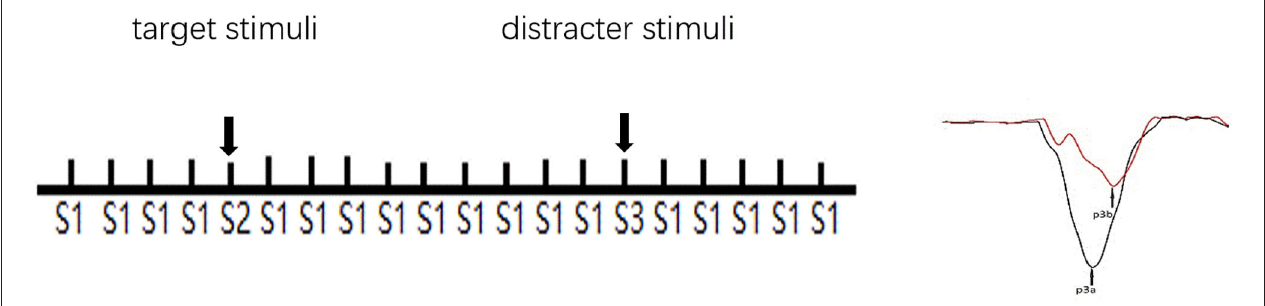
FIGURE 1 | Schematic illustration of the three-stimulus auditory oddball paradigm. S1: standard stimuli. S2: infrequent target stimuli randomly appeared in a background of frequently occurring S1. S3: infrequent distracter stimuli randomly appeared in a background of occurring S1. The subjects were instructed to respond (click the left mouse button) when S2, but not any other stimuli, appeared. S3 elicits a P3a, and S2 elicits a P3b.